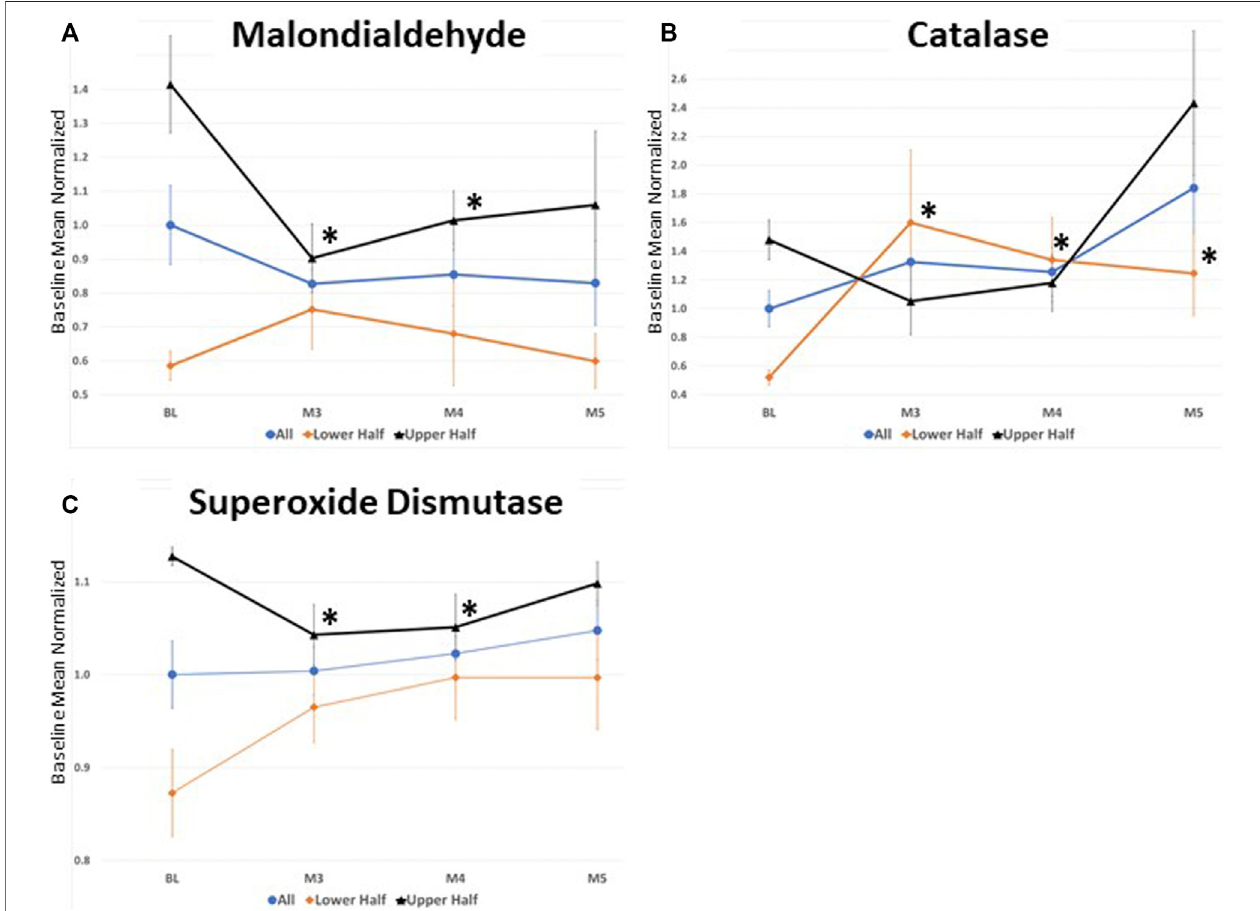
FIGURE 2 | (A) serum Malondialdehyde levels (B) Catalase capacity, and (C) superoxide Dismutase capacity. All values where normalized to the total baseline average. values represent the mean ± SEM. *, p < 0.05 versus baseline of that cohort subset, student ’ s t-test (two-tailed).